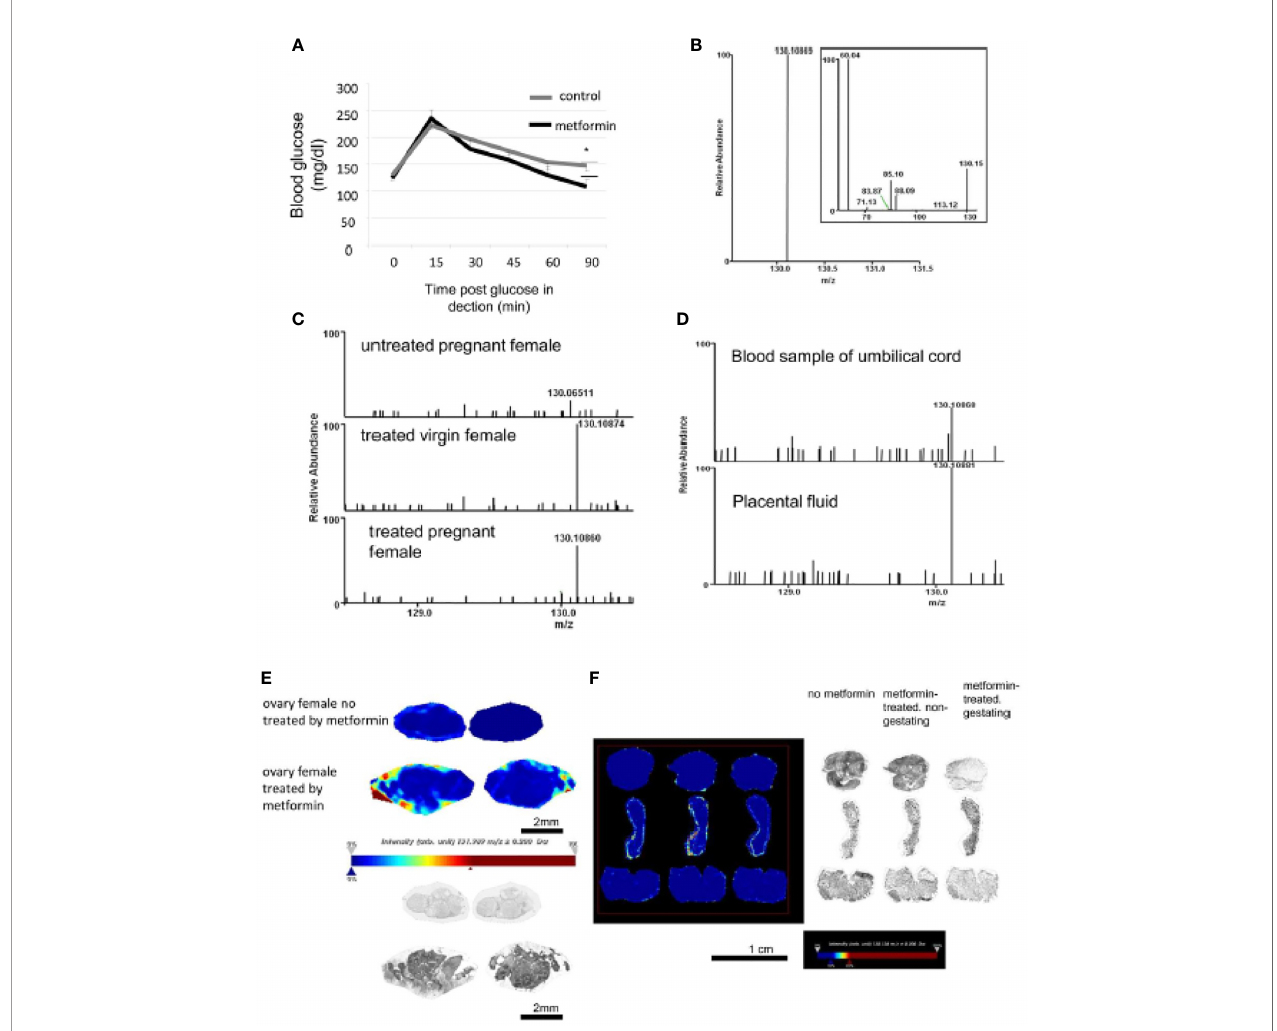
FIGURE 1 | Detection of metformin in biological fl uids of metformin-treated mothers by selected ion monitoring (SIM) mass spectrometry (MS). (A) An OGTT test was performed on E10 pregnant mice treated or not with metformin in drinking water. Values are expressed as mean ± SEM (ctrl n=6 vs met n=7). *p < 0.05. (B) High-resolution selected ion monitoring ( SIM) spectrum of metformin standard, showing the [M+H] + ion at m/z 130.1 ( d mass = -0.26 ppm, theoretical mass 130.10972 computed from molecular formula C 4 H 12 N 5 ). Inset shows the MS/MS spectrum of metformin. (C) SIM spectra of extracts from the blood samples of untreated pregnant female (top), metformin-exposed virgin female (middle, d mass = 0.14 ppm), and metformin-exposed pregnant female (bottom, d mass = 0.94 ppm). The m/z on all spectra are normalized relative to the intensity of the major peak in the scan range of m/z 128.5-131.5 (in this case, the [M+H] + of metformin). (D) SIM spectra of extracts from blood recovered from umbilical cord (top, d mass = -0.32 ppm) and placental fl uid (bottom, d mass = -0.68 ppm). (E) MS imaging of ovary from the mother mice. Image acquired at 30 m m spatial resolution. Pictures showed metformin signal (m/z 130.1) and intensity values are expressed in arbitrary units (a.u.) normalized against the total ion count with a low intensity in blue staining to high intensity in red staining as observed in the intensity bar below the picture. Picture with brightness are in the lower panel. Scale bar 2 mm. (F) MS imaging of uterus from mother mice non-exposed to metformin or non-pregnant or pregnant metformin-exposed female. Pictures showed metformin signal (m/z 130.1) and intensity values are expressed in arbitrary units (a.u.) normalized against the total ion count as observed in the intensity bar below the picture. Picture with brightness is in the right panel. Scale bar 1 cm. We can note an absence of metformin on both uterus